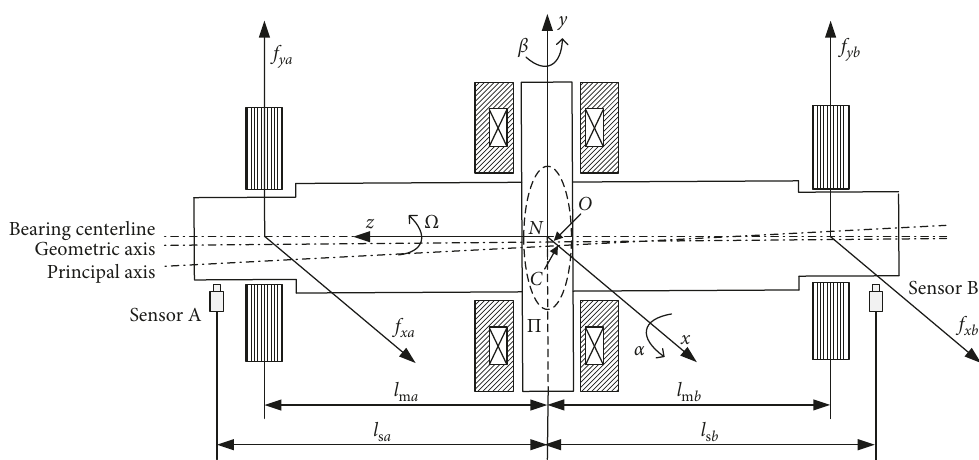
Figure 2: Structure model of the rotor system with AMBs. Table 2: Parameters of the AMB-rotor